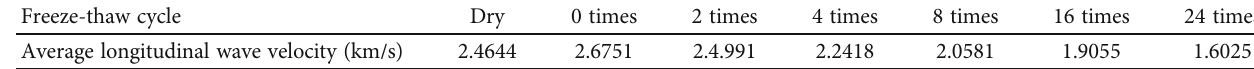
Table 6: Relationship between longitudinal wave velocity and freeze-thaw